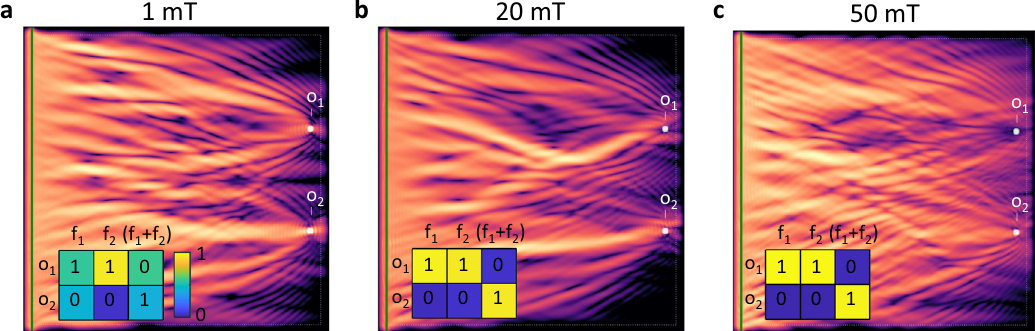
Fig. 4 A simple example of a problem that is not solvable by a linear system. Input is encoded in two frequencies ( f 1 = 3 GHz and f 2 = 4 GHz) and the training function is listed in the inset tables (expected results indicated by numbers, output data are shown in color). a In the linear case (1 mT excitation fi eld), application of simultaneous frequencies results in both o is avoided (correct operation). In case of 50 mT excitation, the distinction is even stronger. The colormap shows integrated wave intensity. The size of the simulation area is 10 μ m × 10 μ